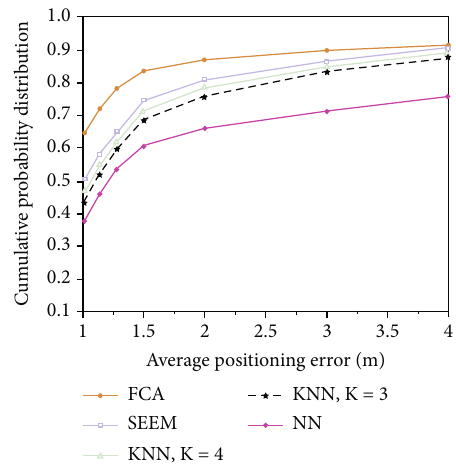
Figure 8: Cumulative error distribution of SEEM algorithm and